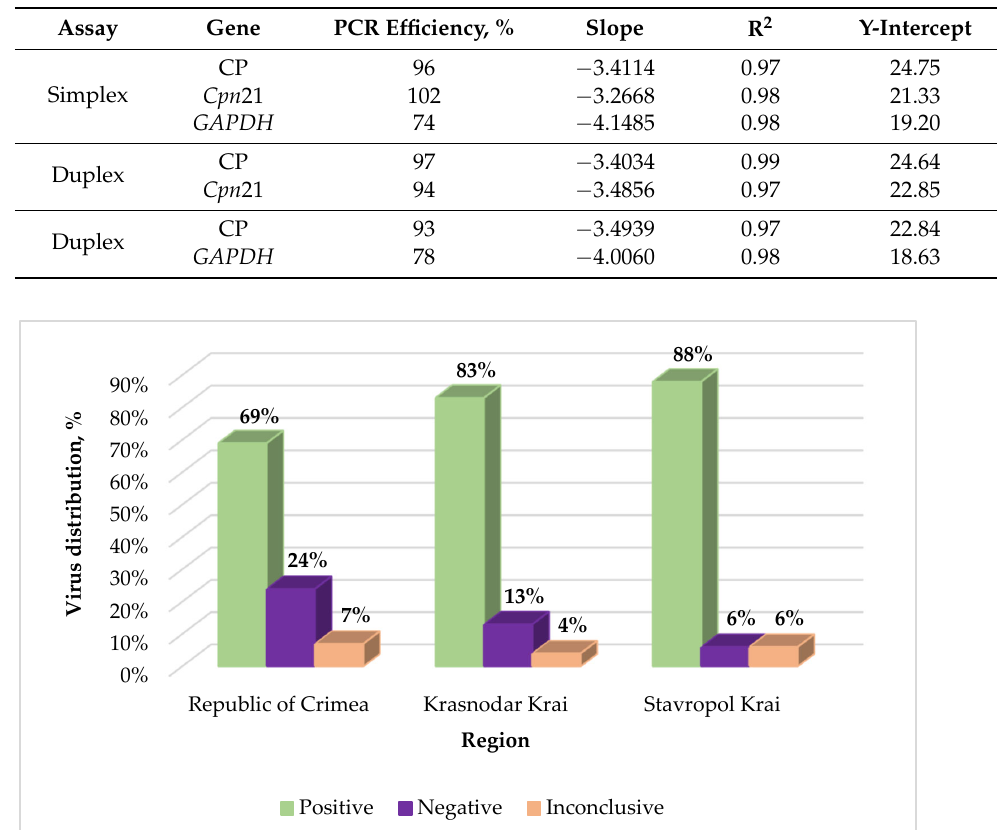
Figure 1. Graphical representation of Grapevine Pinot gris virus monitoring in various regions of Russia. Percentages were calculated from the total number of samples collected in each region.